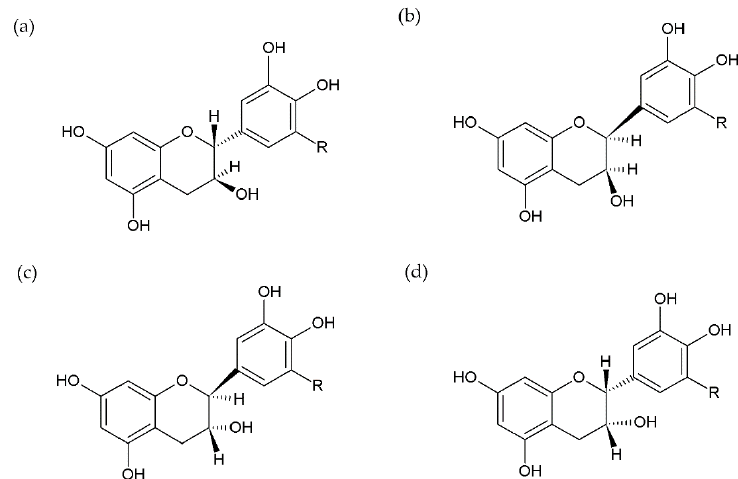
Figure 4. Diasteroisomers of catechin. Adapted from References [20,30]. ( a ) (+)-catechin (R = H); (+)-gallocatechin (R = OH); ( b ) (+)-epicatechin (R = H); (+)-epigallocatechin (R = OH); ( c ) (−)-catechin (R = H); (−)-gallocatechin (R = OH); ( d ) (−)-epicatechin (R = H); (−)-epigallocatechin (R = OH).